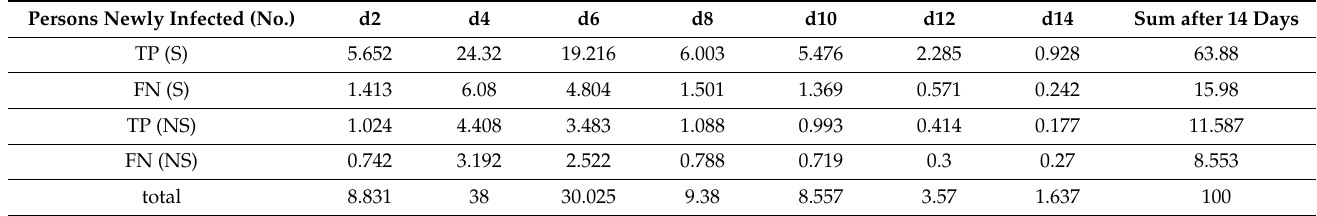
Table 2. Number of infected HCW under quarantine on different days.